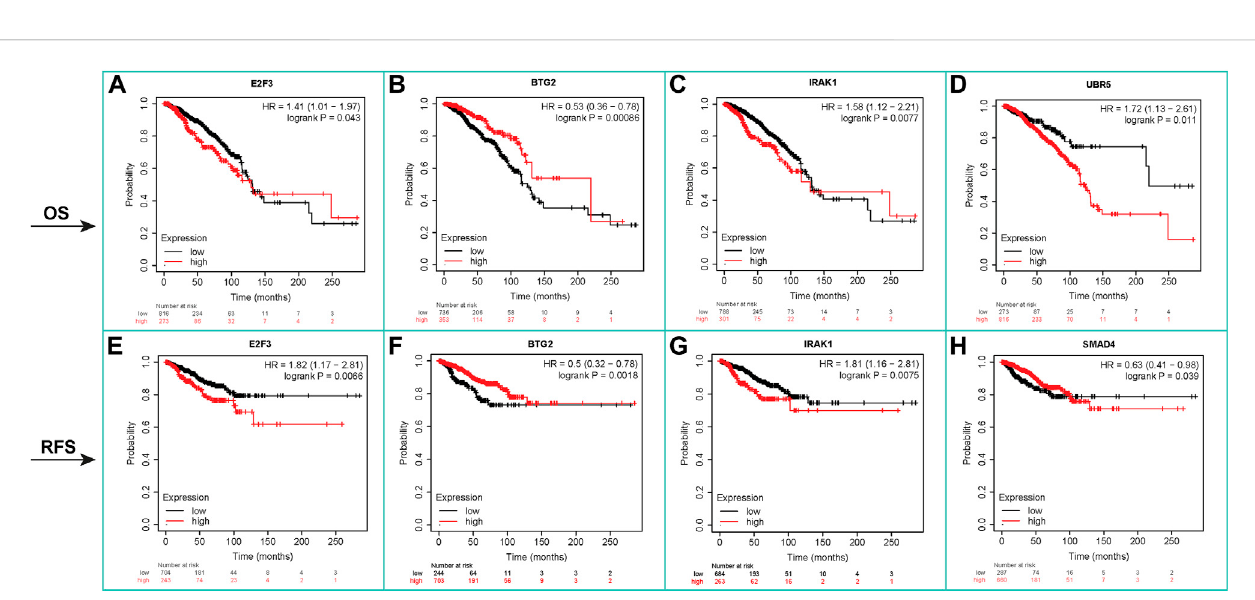
FIGURE 6 Kaplan – Meier survival analysis, OS, and RFS for mRNAs. It showed that increased expressionof E2F3 (HR = 1.41), IRAK1 (HR = 1.58),and UBR5 (HR = 1.72) indicatedpoorOSprognosis,while decreasedexpressionofBTG2(HR=0.53)isanindicatorofpoorOS.RFSanalysisrevealedthat higherexpressionlevelsof E2F3 (HR = 1.82) and IRAK1 (HR = 1.81) are associated with poor RFS prognosis. Lower expression levels of BTG2 (HR = 0.50) and SMAD4 (HR = 0.63) are associated with poor RFS prognosis in